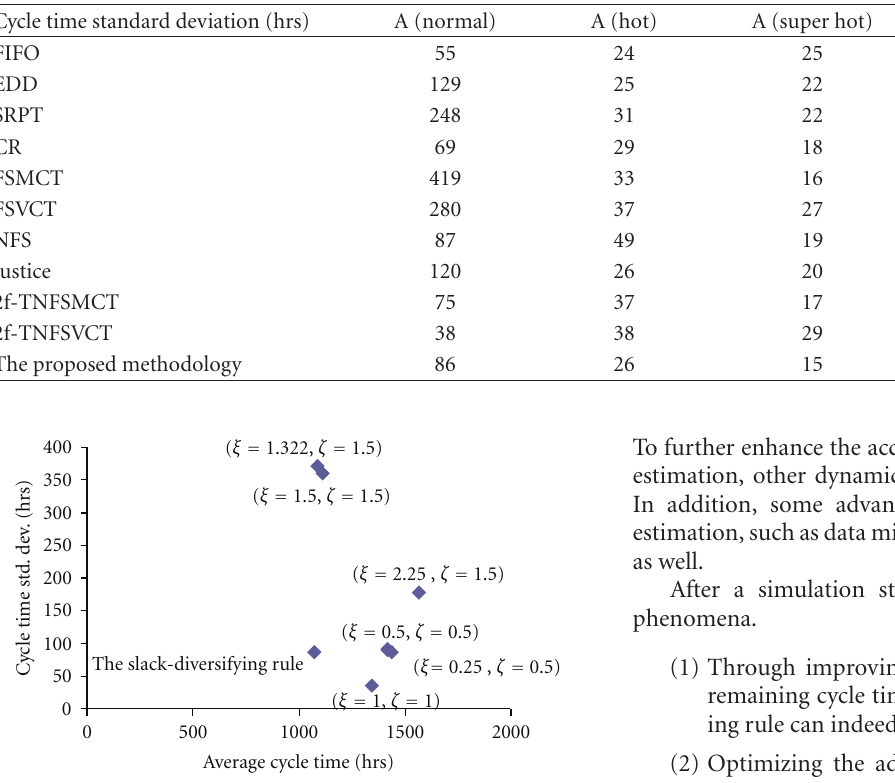
Table 4: The performances of various approaches in cycle time standard deviation.